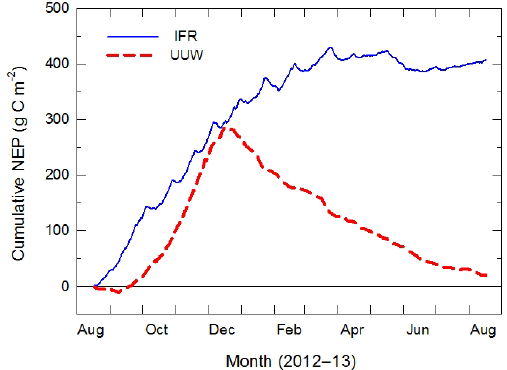
Figure 6. Cumulative net ecosystem production for the irrigated, fertilised and rotationally grazed (IFR) and the unirrigated, unfer- tilised and winter-grazed (UUW) pasture. Positive values represent C uptake by the ecosystem.